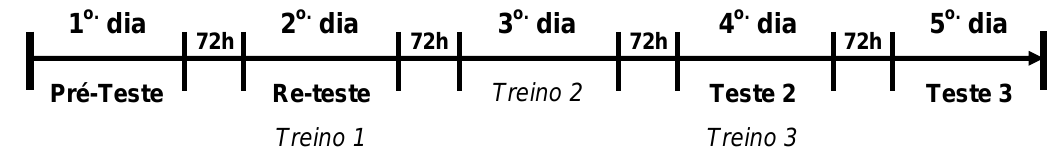
Figura 1 . Delineamento do